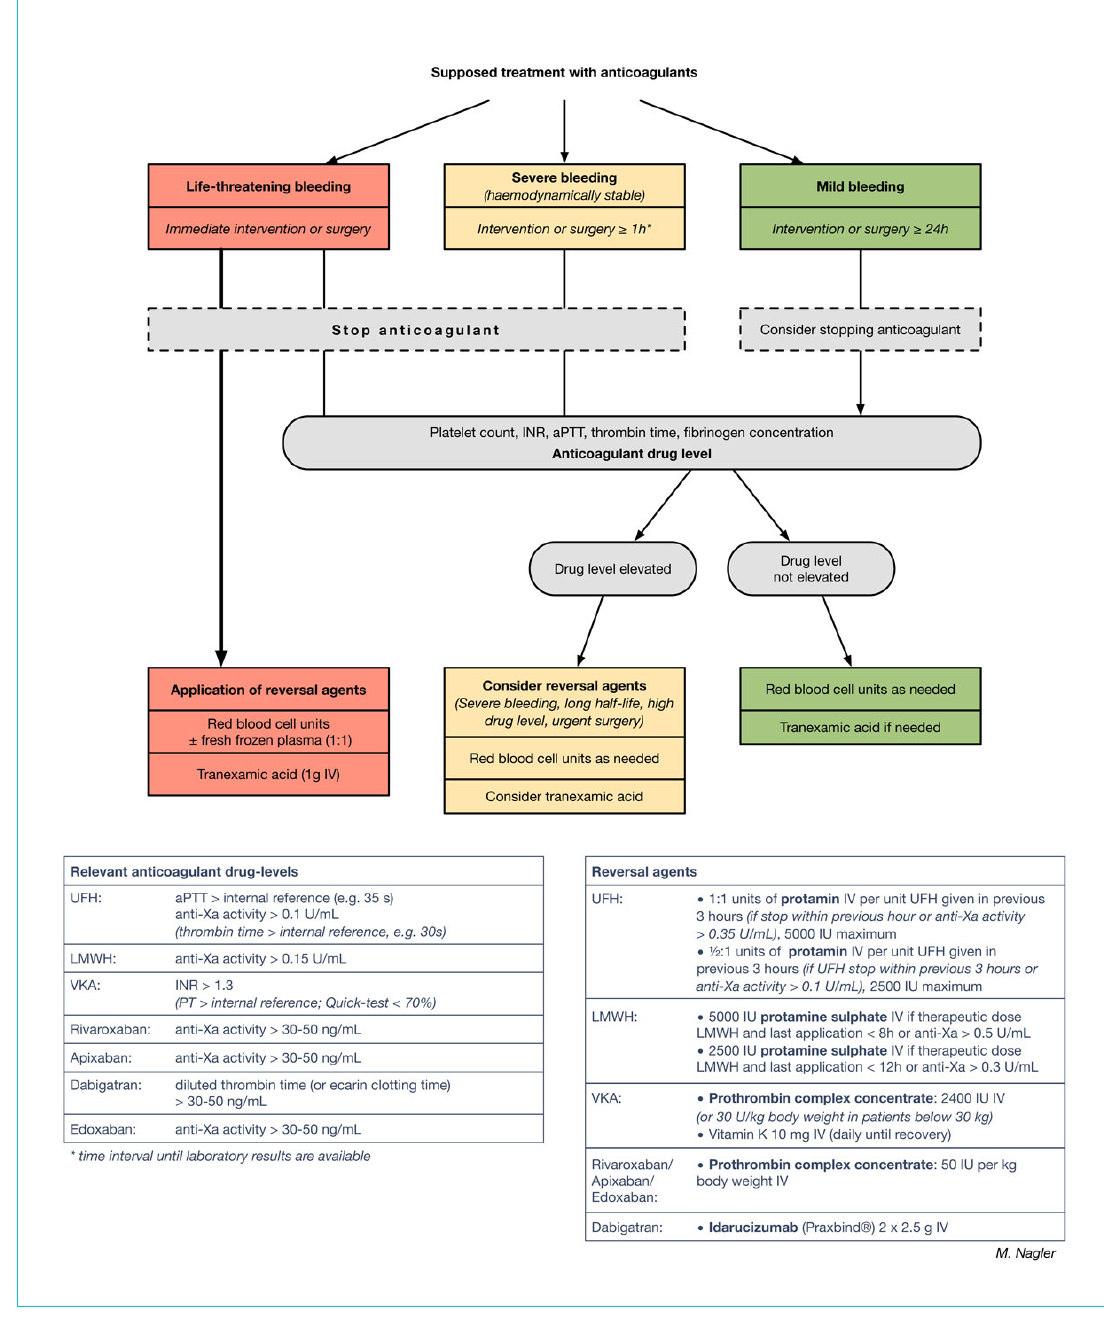
Figure 1: Management of patients with anticoagulant-associated bleeding or urgent surgery. Proposal for a treatment algorithm detailing labo- ratory tests, cut-off values and administration of reversal agents.INR = international normalised ratio; aPTT = activated partial thromboplastin time; UFH = unfractionated heparin; LMWH = low molecular weight heparin; VKA = vitamin K antagonists. A larger version of this figure is downloadable from